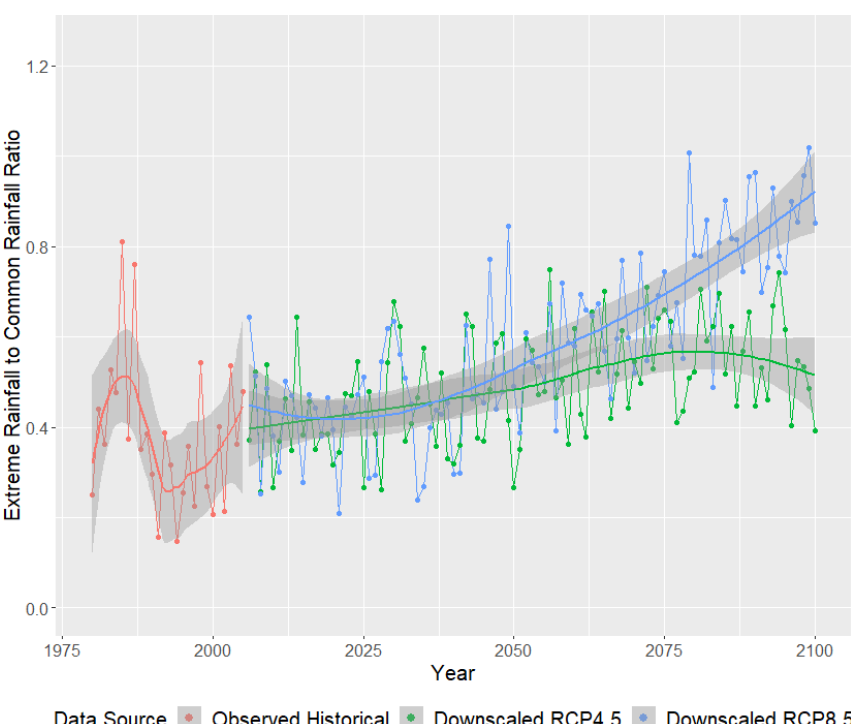
Figure 16. CanESM2 ratio of yearly high-magnitude rainfall (HMR) event total rainfall (island daily average > 14 . 81 mm) to common rainfall as a function of year. This figure was created using Wickham